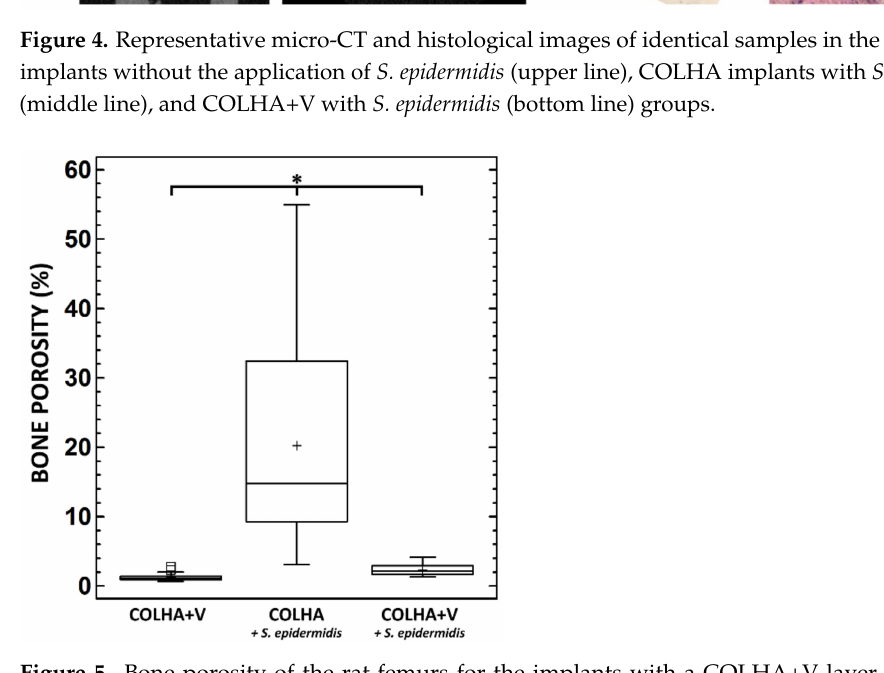
Figure 5. Bone porosity of the rat femurs for the implants with a COLHA+V layer and for the implants with COLHA and COLHA+V layers with S. epidermidis . * Denotes statistically significant differences (0.05, Kruskal–Wallis with the Bonferroni